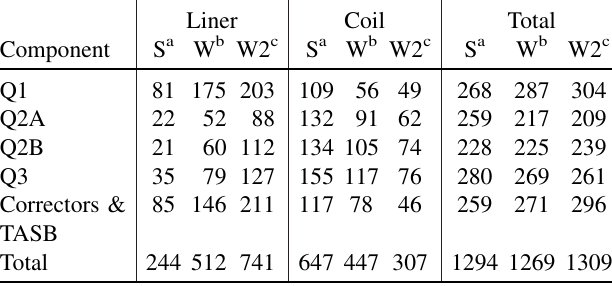
TABLE I. Integral data on the dynamic heat load ( W = m ) for the inner triplet with 100-mm Nb Sn quadrupoles at an ultimate 3 luminosity of 10 35 cm (cid:1) 2 s (cid:1) 1 . Steel and W25 Re liners of base- line thickness as well as a W25 Re liner of increased thickness are considered. Liner Coil Total